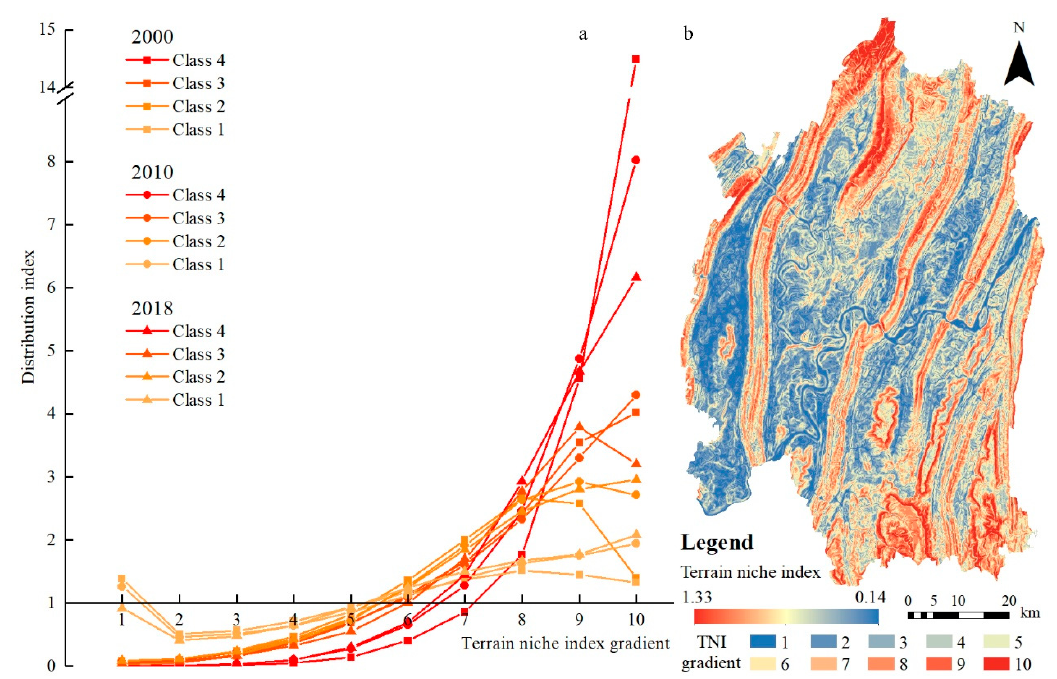
Figure 6. Distribution index ( a ) of multiple ES hotspots in terrain niche index gradient ( b ).